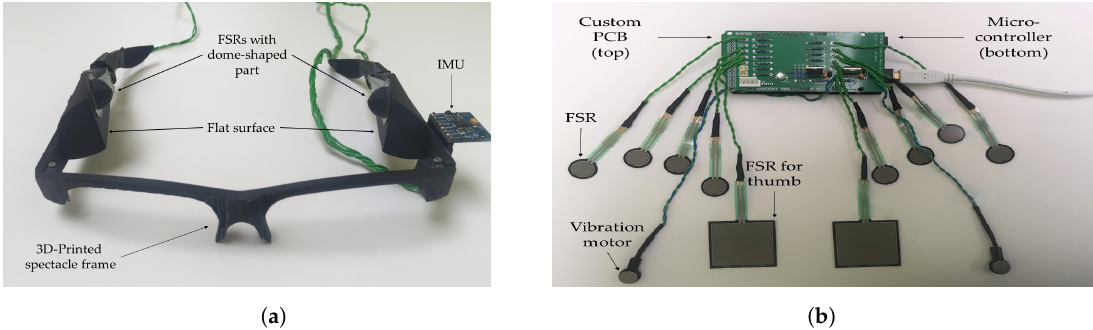
Figure 4. Implementations of the head-mounted mouse alternative ( a ); and the keyboard interface including the microcontroller board and electronics ( b ).